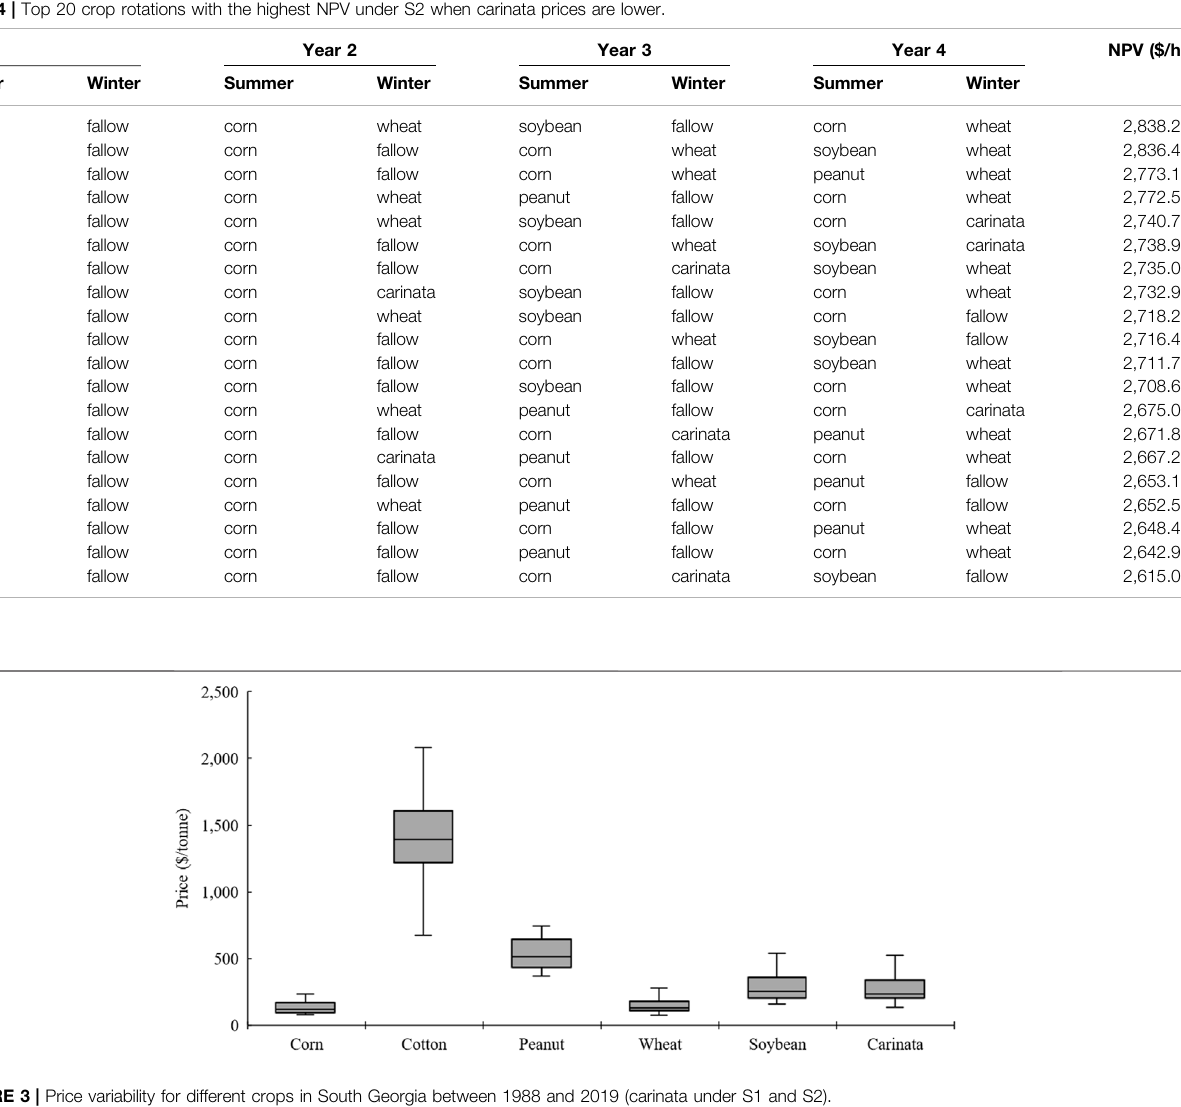
Frontiers in Energy Research |